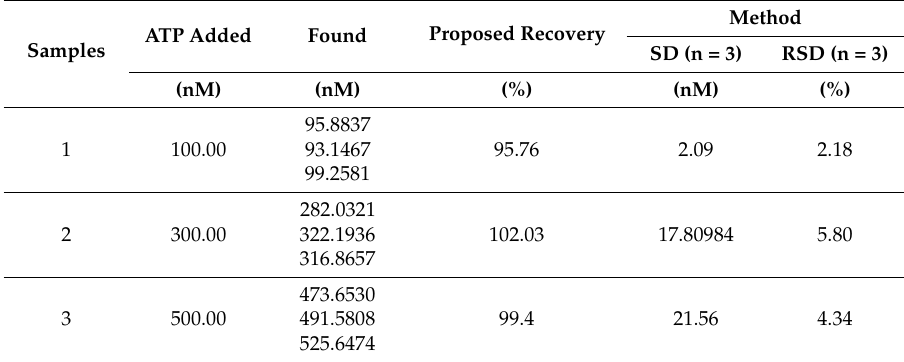
Table 4. Detection of different ATP concentrations in real